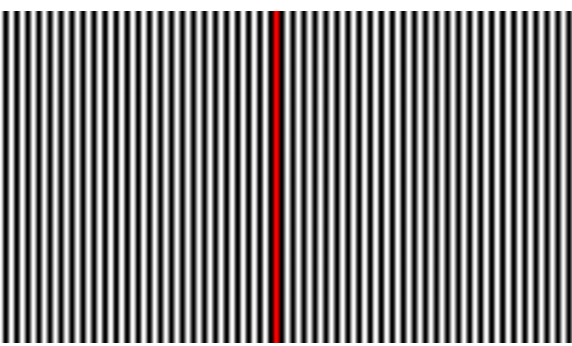
Figure 2. A fringe pattern with period T p , with a central red-coloured